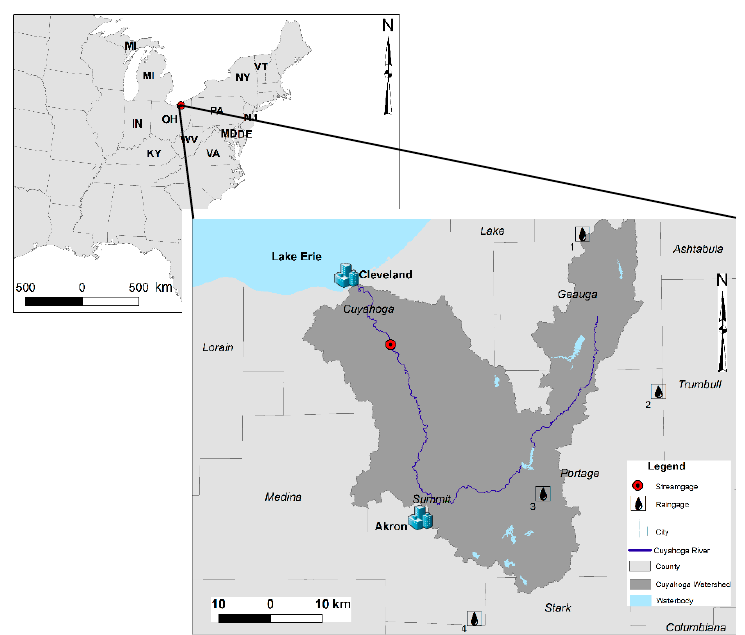
Figure 1. The Cuyahoga watershed and study area. (Map data from Ohio Department of Natural Resources, United States Census Bureau, United States Geological Survey, National Oceanic and Atmospheric Administration.)